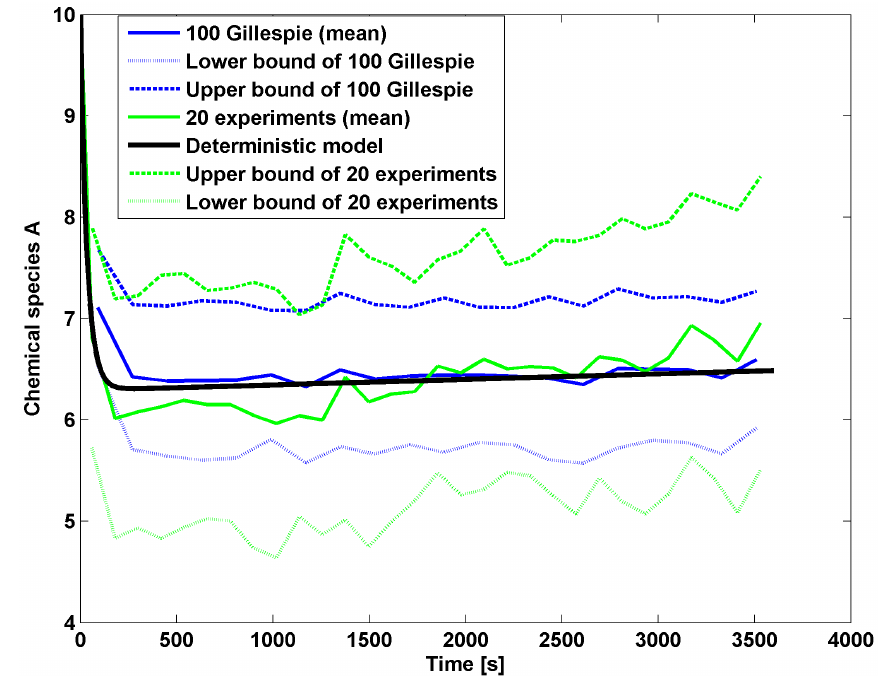
Figure 4. Fitting abundance of species A. Blue curve: average of 100 simulations of the stochastic model with Gillespie algorithm. Green curve: average of the experimental data. Red dotted and dash-dotted curves indicate the variance. The black line is the solution of the deterministic chemical model for the species A .